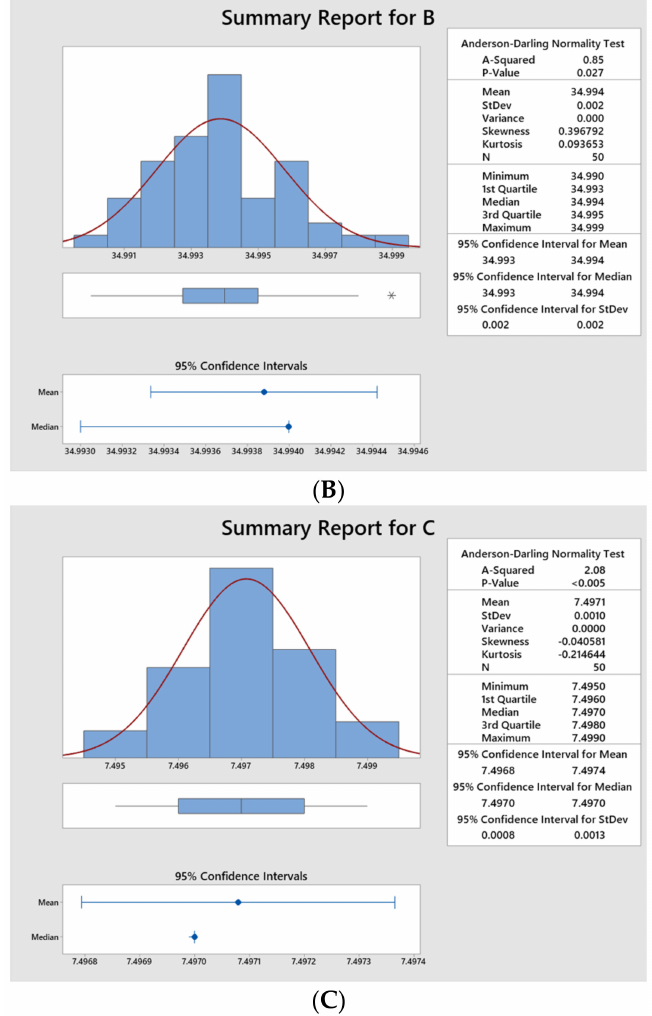
Figure 3. Dimension distribution of parts of ball bearing assembly. Part ( A )—negatively skewed normal distribution; Part ( B )—positively skewed normal distribution; Part ( C )—negatively skewed non-normal distribution.